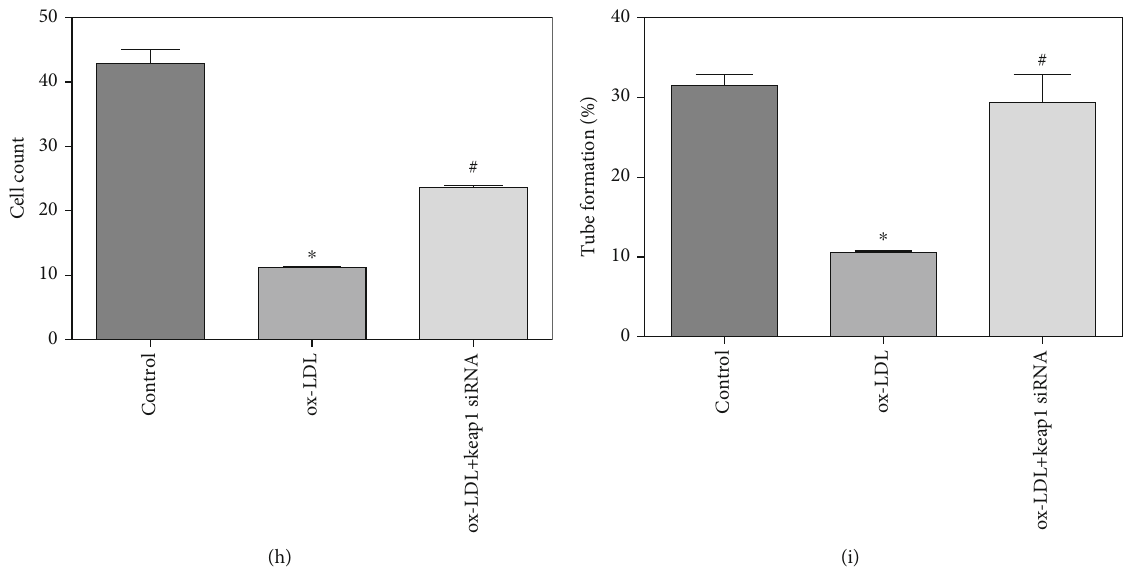
Figure 4: ox-LDL impaired EPC migration and tube formation and induced apoptosis via Nrf2 or p38 pathway. EPCs were pretreated with Keap1 siRNA or 1 μ M SB203580 and then exposed to ox-LDL (20 μ g/mL) for 6 hours. (a) Apoptosis was determined through Annexin V- FITC and PI double-staining using fl ow cytometry after ox-LDL or 1 μ M SB203580 treatment for 6 hours. ox-LDL increased the apoptotic rate of EPCs. Pretreatment of SB203580 reduced the apoptotic rate of EPCs. (b, c) EPC apoptosis was quanti fi ed by manually counting pyknotic nuclei after DAPI (Sigma-Aldrich) staining. ox-LDL increased the apoptotic rate of EPCs. Pretreatment of SB203580 reduced the apoptotic rate of EPCs. Scale: 100 μ m. (d) Represented Western blot images of the protein expressions of Bax and Bcl-2 in EPCs after treatment of ox-LDL or Keap1 siRNA. (e) Quanti fi cation of relative quantity of Bax and Bcl-2 showed that ox-LDL signi fi cantly increased Bax/Bcl-2 ratio, which was blocked by the pretreatment of Keap1 siRNA transfection. Migration of EPCs was examined by transwell chemotaxis assay. (f) The representative images of migrated EPCs in the control group, ox-LDL group, and Keap1 siRNA pretreatment plus the ox-LDL group (magni fi cation: × 100). Scale: 50 μ m. (g) The presentative photomicrographs of tube formation of EPCs under the treatment of ox-LDL and Keap1 siRNA pretreatment. Scale: 200 μ m. (h) Quantitative data show that ox-LDL signi fi cantly reduced the numbers of migrated EPCs, but Keap1 siRNA signi fi cantly increased the numbers of migrated cells. Values are the means ± SD from 3 independent experiments. The angiogenic function of EPCs under exposure to ox-LDL or Keap1 siRNA was determined by tube formation assay. (i) Quanti fi cation analysis of the number of tube branches showed that Keap1 siRNA pretreatment ameliorated EPC angiogenic function which were inhibited by ox-LDL. ∗ p < 0 : 01 vs. control. # p < 0 : 01 vs. ox-LDL